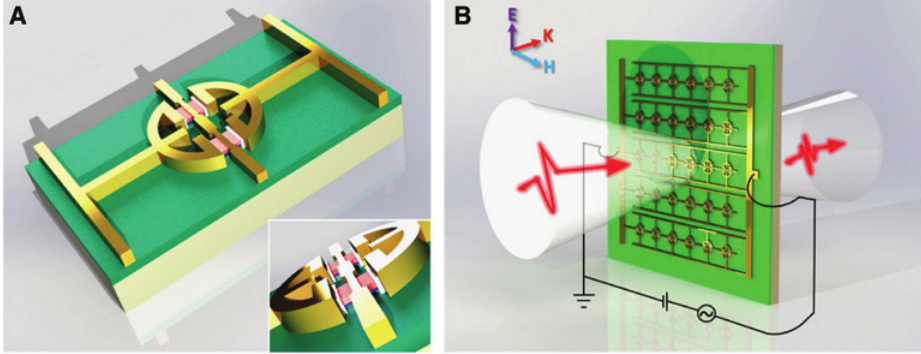
Figure 1: Structures of the enhanced resonant metamaterial embedded with nanostructured 2DEG layer: (A) 3D structure of a unit cell and (B) schematic of the phase